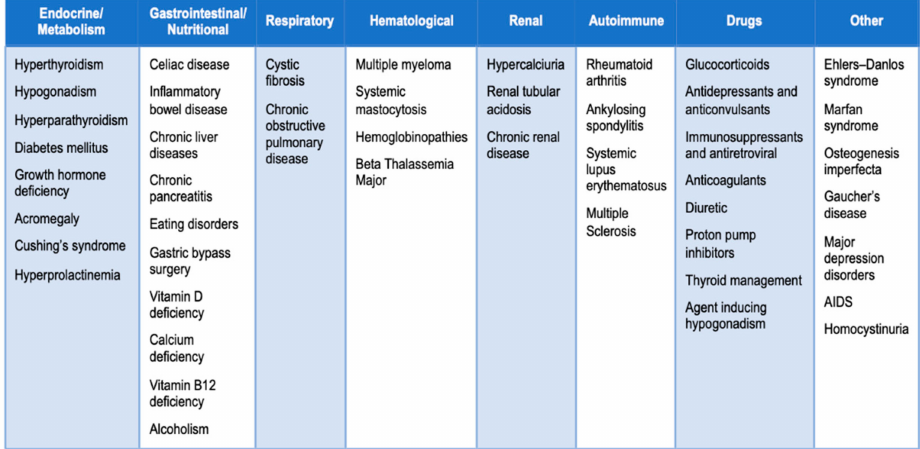
Figure 1. Common causes of secondary osteoporosis. Osteoporosis can be divided into two major subtypes: primary osteoporosis is a condition that develops in postmenopausal women and in elderly people, while secondary osteoporosis is referred as bone loss caused by specific clinical diseases or therapies